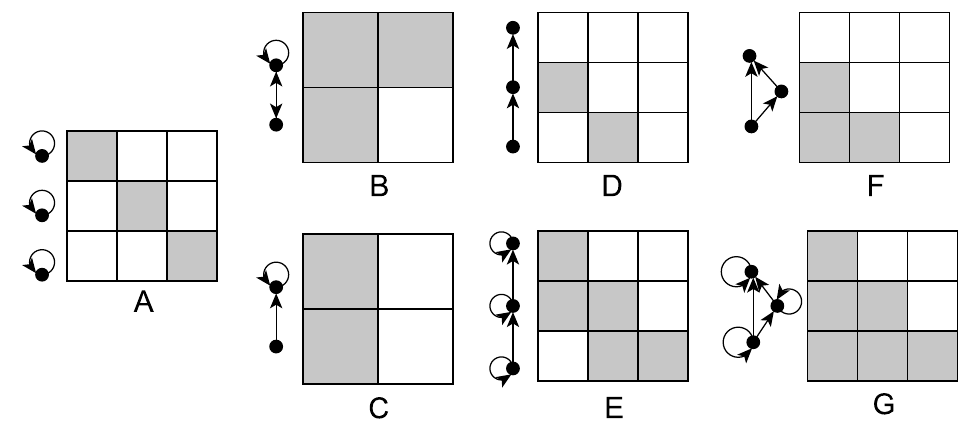
Fig 3. Different types of blockmodel structures: Graph (left) and matrix (right) representation. (A) cohesive, (B) symmetric core-periphery, (C) asymmetric core-periphery, (D) hierarchical without complete blocks on the diagonal, (E) hierarchical with complete blocks on the diagonal, (F) transitive without complete blocks on the diagonal, (G) transitive with complete blocks on the diagonal; gray colored cells denote complete blocks while white colored cells denote null